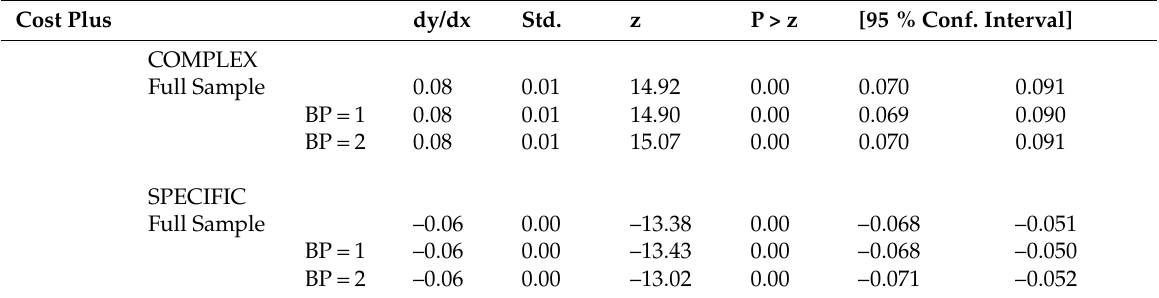
Table 7: Predictive margins for CP. Cost